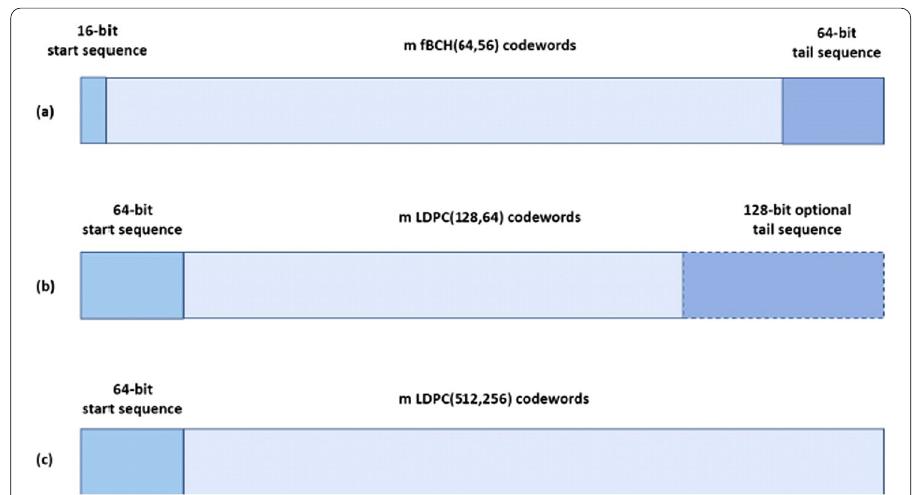
Fig. 10 CLTU structure for the three coding options (not in scale, total CLTU length depends on the number of